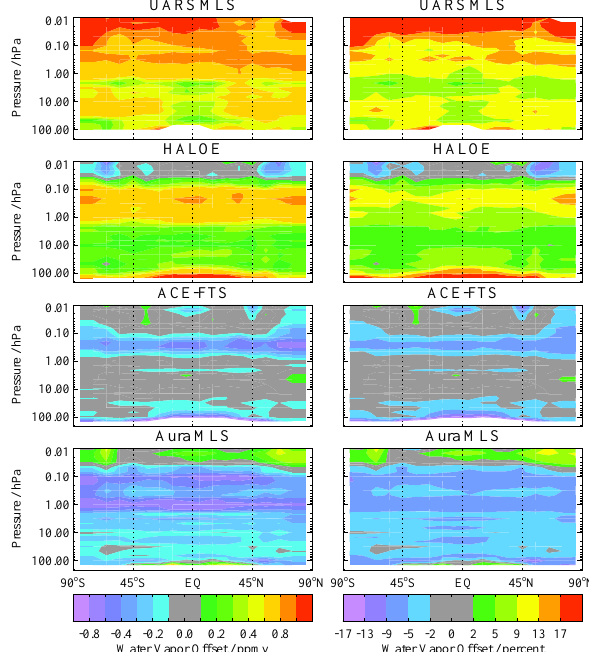
Figure 10. Offsets applied to the H 2 O source data sets as a function of latitude and pressure, similar to Fig. 2 for